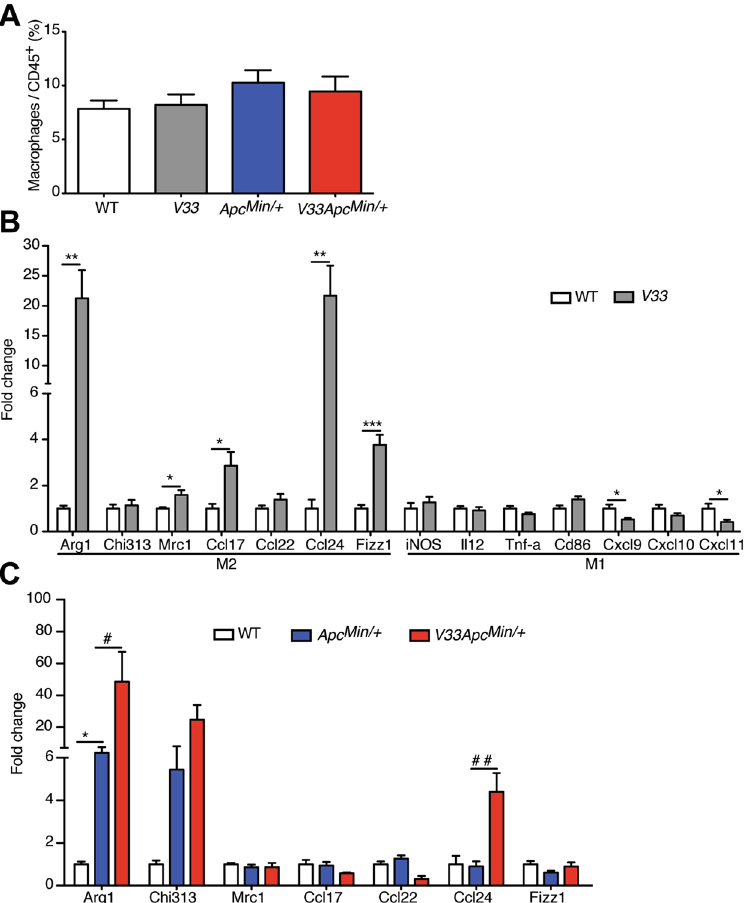
Figure 6. IL-33 regulates alternative activation of colonic macrophages. ( A ) Relative number of macrophages (CD45 + CD11b + F480 + ) in the colon of WT, V33 , Apc Min/ + mice and V33 Apc Min/ + mice at d120. Graphs show means ± s.e.m., n = 3–5/group. ( B ) Relative expression levels of M1 and M2 macrophage signature genes were analyzed by qPCR in sorted macrophages of colonic lamina propria of WT mice and V33 mice at d120. ( C ) Relative expression levels of M2 macrophage signature genes were analyzed by qPCR in sorted macrophages of colonic lamina propria of WT mice, Apc Min/ + mice and V33 Apc Min/ + mice at d120. Data were normalized to fold change from age-matched WT littermate control mice. Graphs show means ± s.e.m., n = 3–5/group. * P < 0.05, ** P < 0.01, *** P < 0.001, versus WT group. # P < 0.05, ## P < 0.01, versus Apc Min/ +